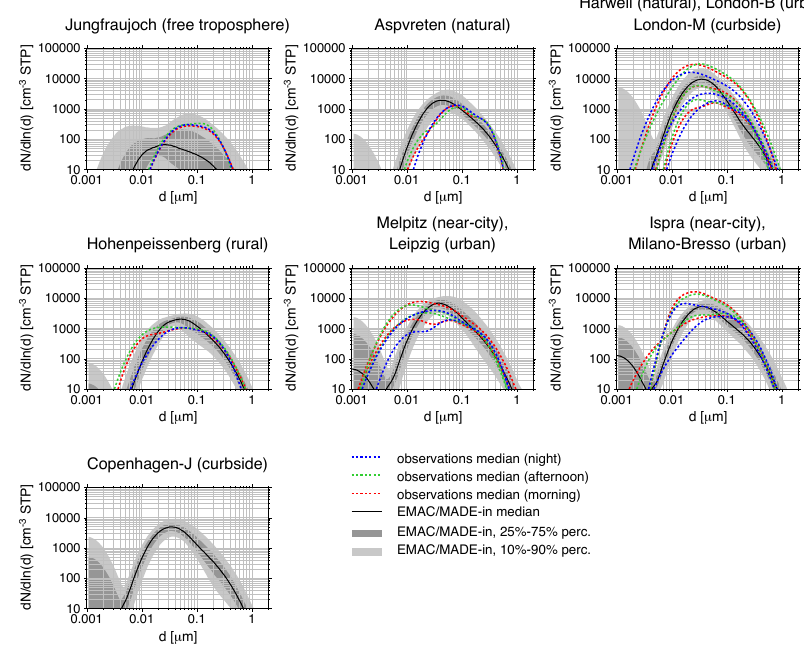
Fig. 13. As Fig. 12 but for summer (June, July, August). No measurements at the Copenhagen site are